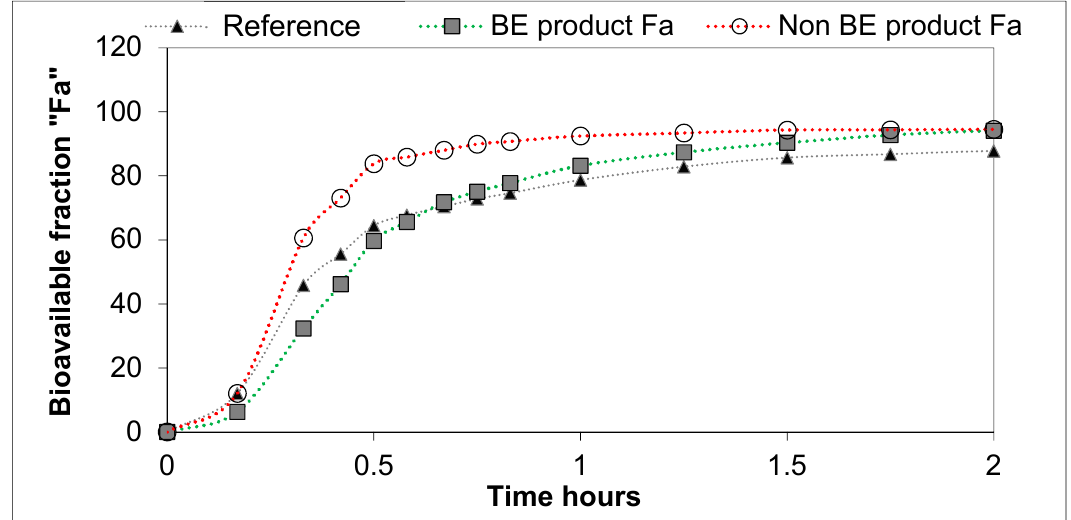
Figure 5. Bioavailable DKT fractions obtained from plasma levels through Loo–Riegelman deconvolution.